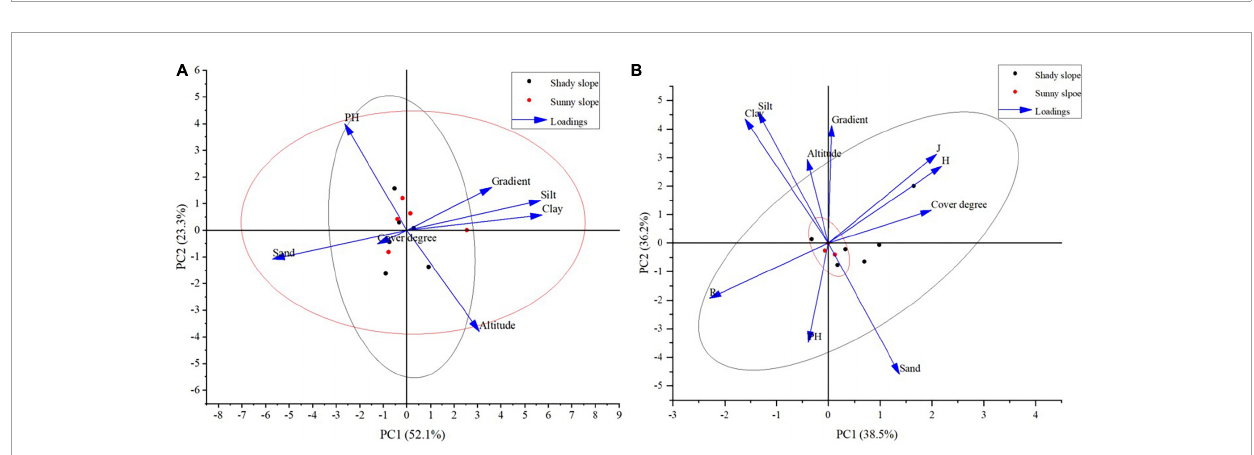
FIGURE7 Principal component analysis of different environmental factors and herb diversity index. (A) Principal component analysis of environmental factors. (B) Correlation between environmental factors and diversity indices.